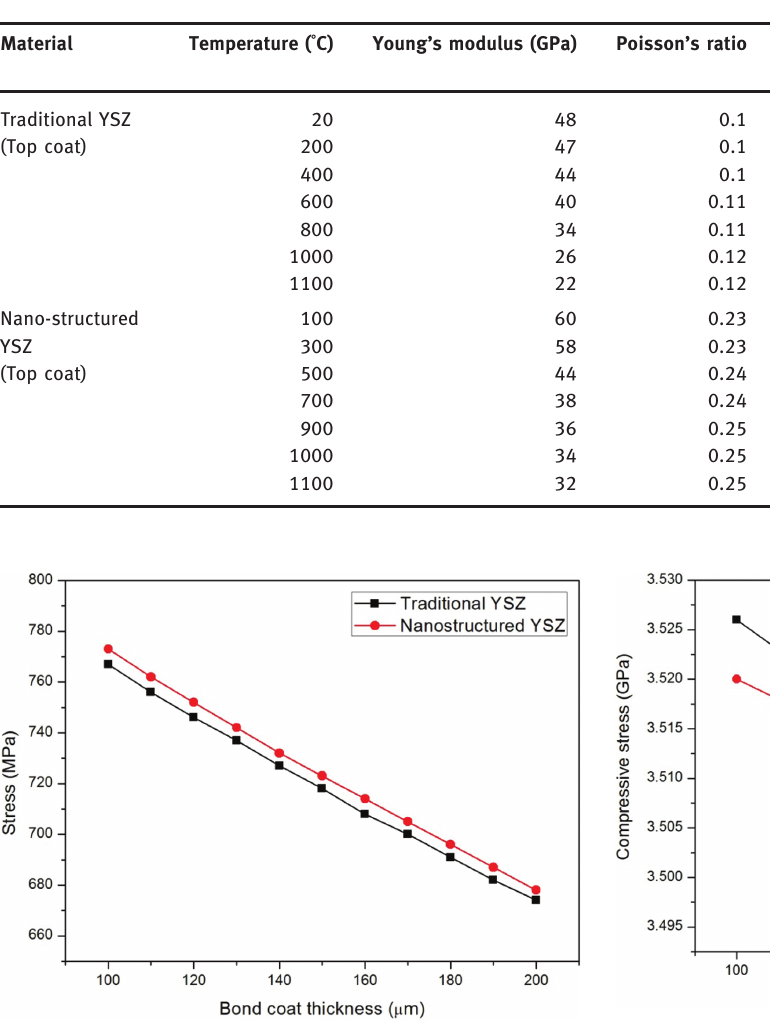
Figure 3: Radial compressive stress in traditional and nanostruc- tured YSZ coatings as a function of bond coat thickness.